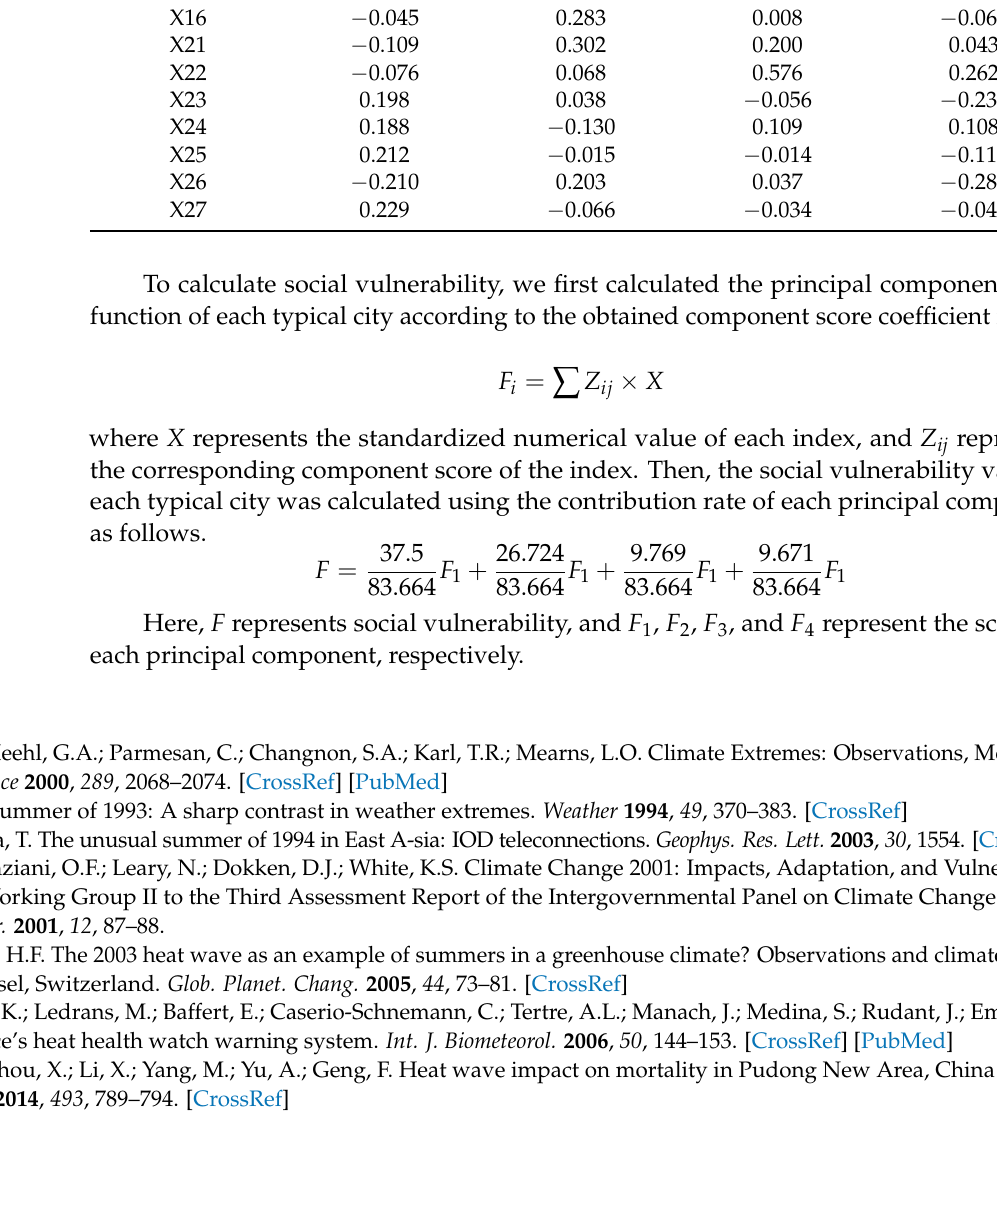
Table A2. Component function matrix. Components of Component Function Matrix